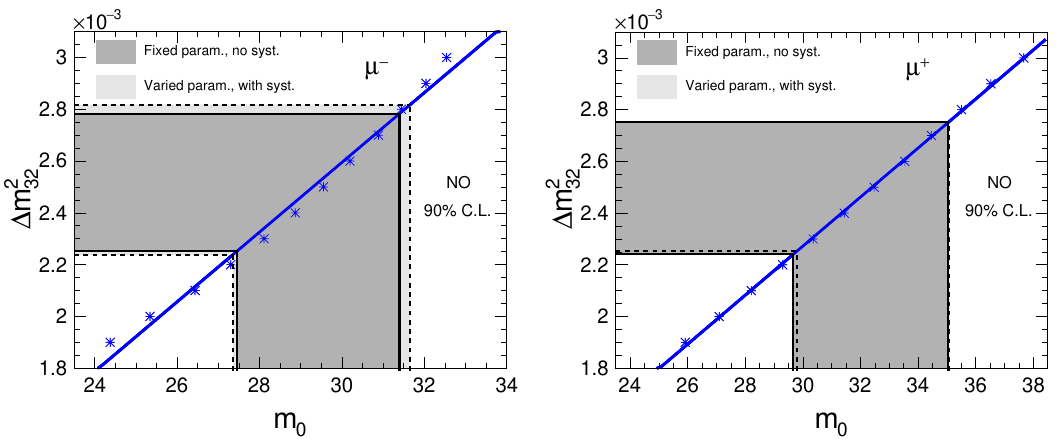
against m , Figure 9 . The blue stars and the blue lines indicate the calibration curves of ∆ m 2 0 32 obtained using 1000-year MC data with normal mass ordering. The gray bands represent the 90% C.L. allowed ranges of m (vertical bands), and hence of ∆ m 2 (horizontal bands), with a given 0 32 input value of ∆ m 2 = 2.46 × 10 − 3 eV 2 , for an exposure of 10 years at ICAL. The results for µ − 32 and µ + events are shown separately, in the left and right panels, respectively. The light (dark) gray bands show the ranges when the errors on other oscillation parameters and the impact of systematic uncertainties are included (excluded), as discussed in section 4.2. For fixed-parameter case, we use the benchmark oscillation parameters given in table